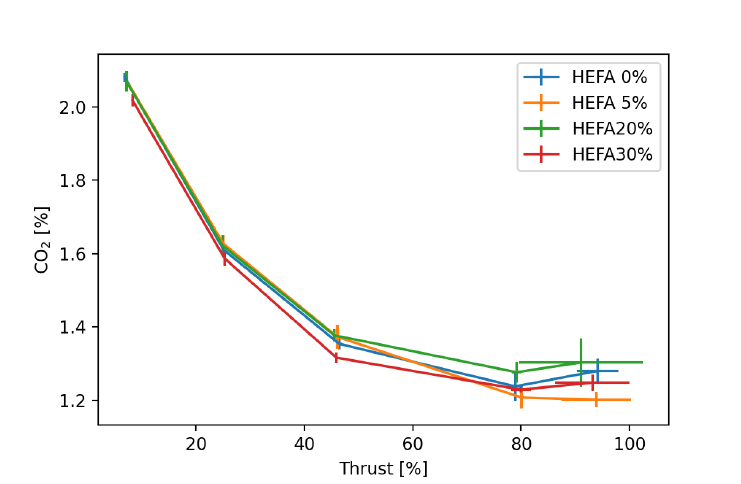
Figure 20. GTM-140/HEFA: CO 2 emission.